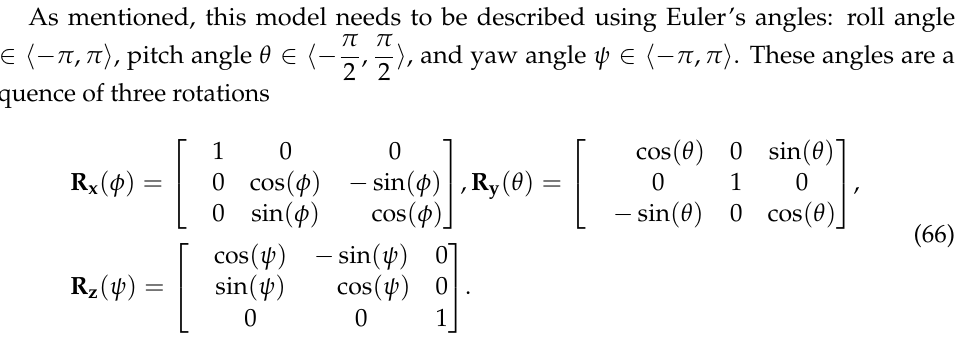
Figure 1. Structure of a quadrotor